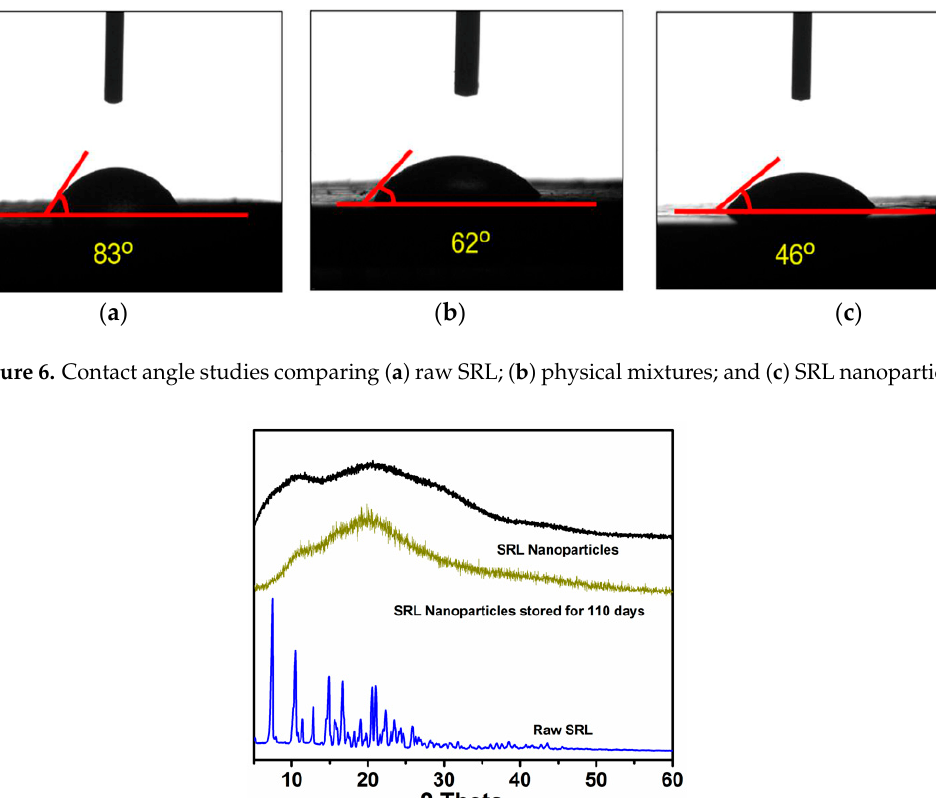
Figure 6. Contact angle studies comparing ( a ) raw SRL; ( b ) physical mixtures; and ( c ) SRL nanoparticle.